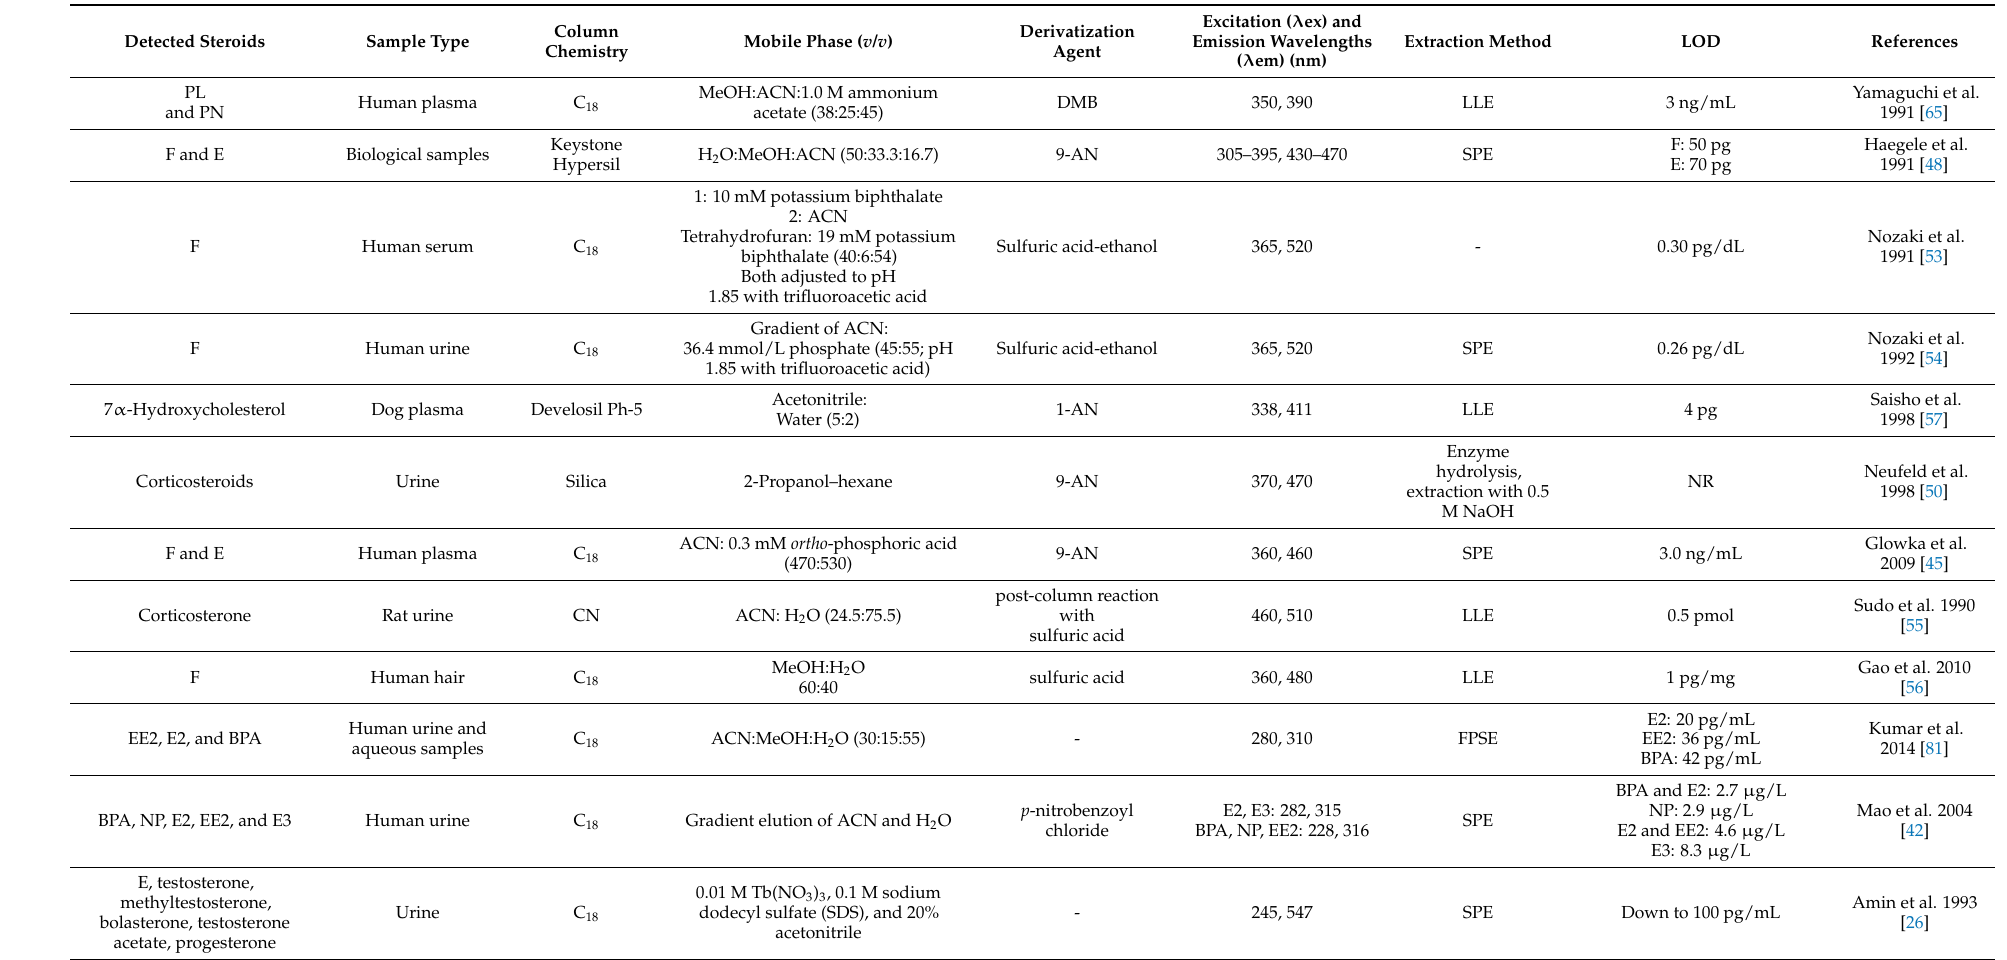
Table 2. HPLC-FLD method conditions used for steroid